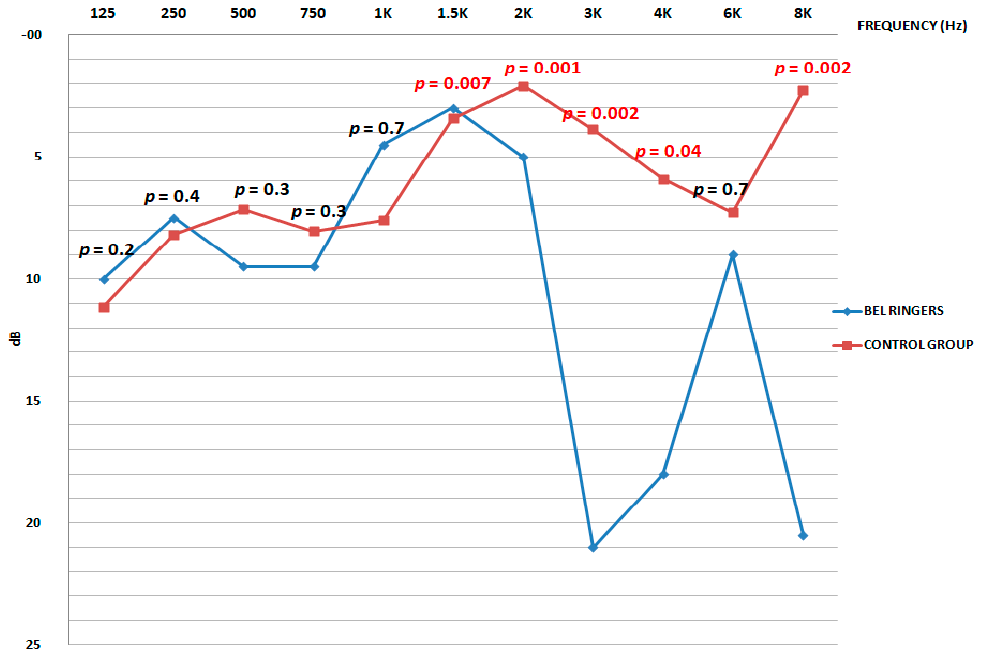
Figure 14. Average hearing threshold obtained from the audiometry of frequencies from 125 to 8000 Hz with age correction. Table 10. Results obtained from the audiometry of frequencies from 125 to 8000 Hz with age correction. Di ff erence between Hearing Threshold Frequency Average Discomfort Threshold